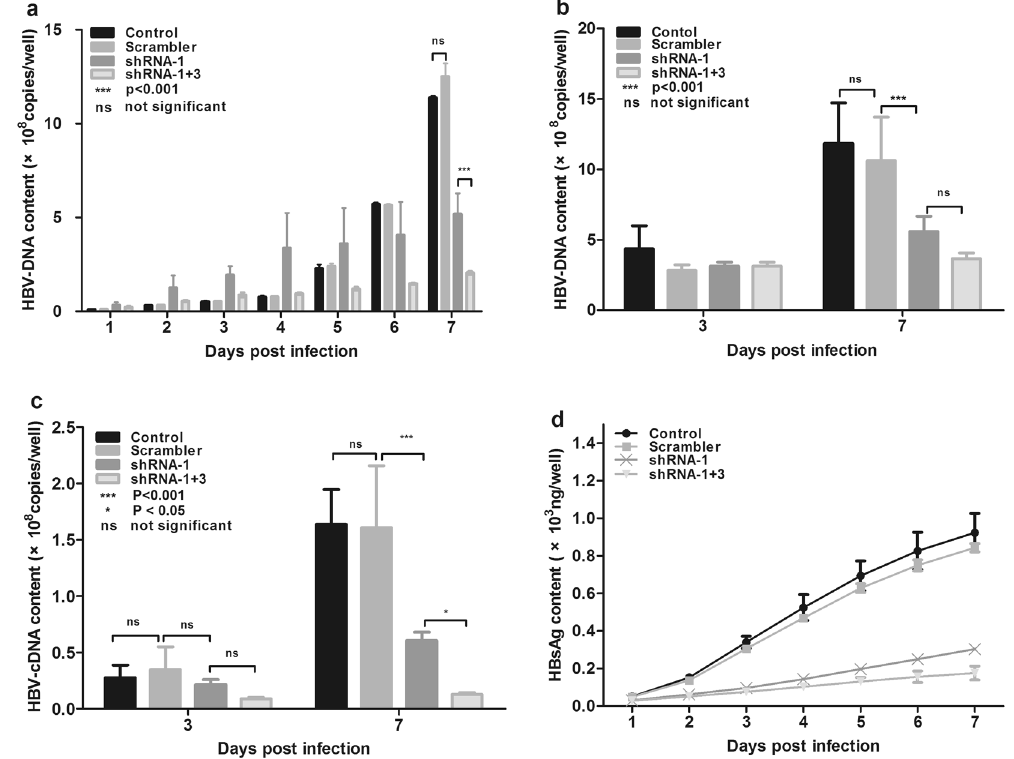
Figure 3. Dual-shRNA has a stronger inhibitory effect on HBV replication than single shRNA in HepG2.2.15 cells. HepG2.2.15 cells were infected with AAV vectors containing single or dual shRNAs at a MOI of 2000. Supernatants and cells were collected separately at the indicated time points post infection. Changes of HBV DNA in supernatants ( a ) and cells ( b ), HBV RNA in cells ( c ), and HBsAg in supernatants ( d ) were monitored during a 7 day period. Control, PBS treatment; scrambler, vector containing the shRNA sequence not targeted to the HBV genome. P < 0.05: significant difference. Ns: the difference was not significant. Data represent the mean ± SD of three independent